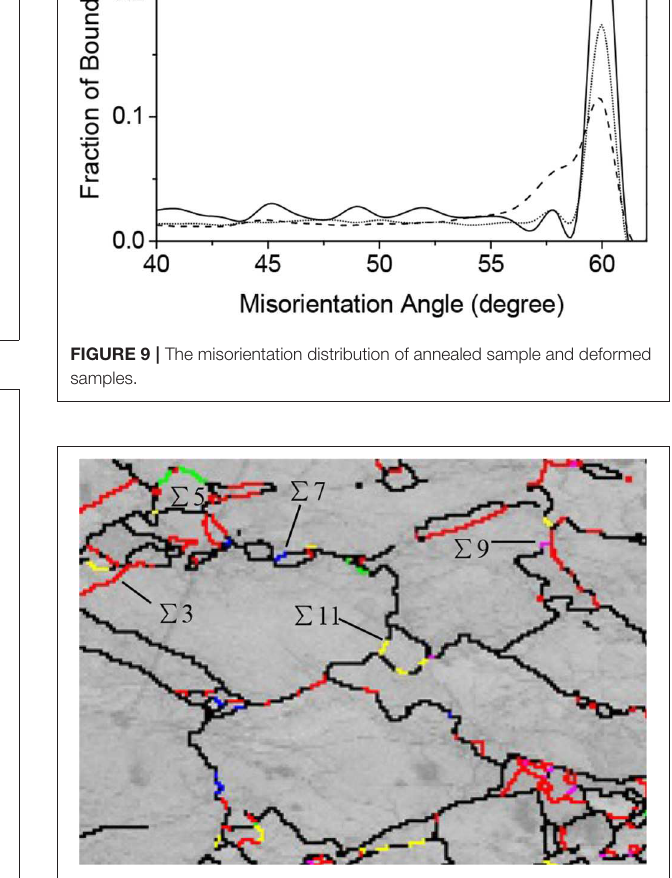
FIGURE 8 | Average grain size vs. strain.